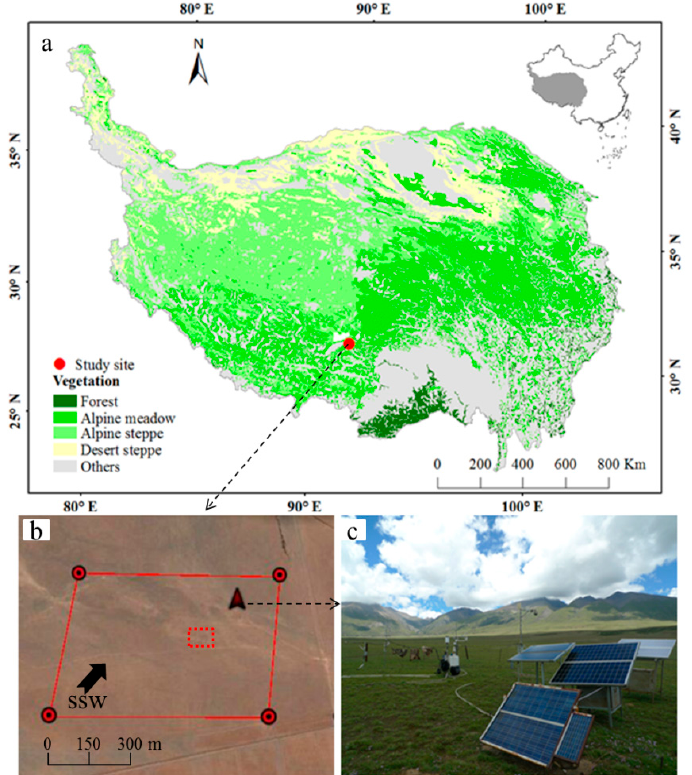
Figure 2. Site descriptions of this typical alpine steppe ― Korbresia meadow at the Damxung grassland station: ( a ) Vegetation type of the Qinghai-Tibet Plateau and the geographical location of this study. ( b ) The position of flux-tower (red arrow), chamber-based observation field (red dotted box), and the corresponding MODIS 0.5 km × 0.5 km pixel (red solid box). The black arrow represents the direction of prevailing wind (SSW, south-southwest) in this alpine meadow. ( c ) Real photo of this observational field.